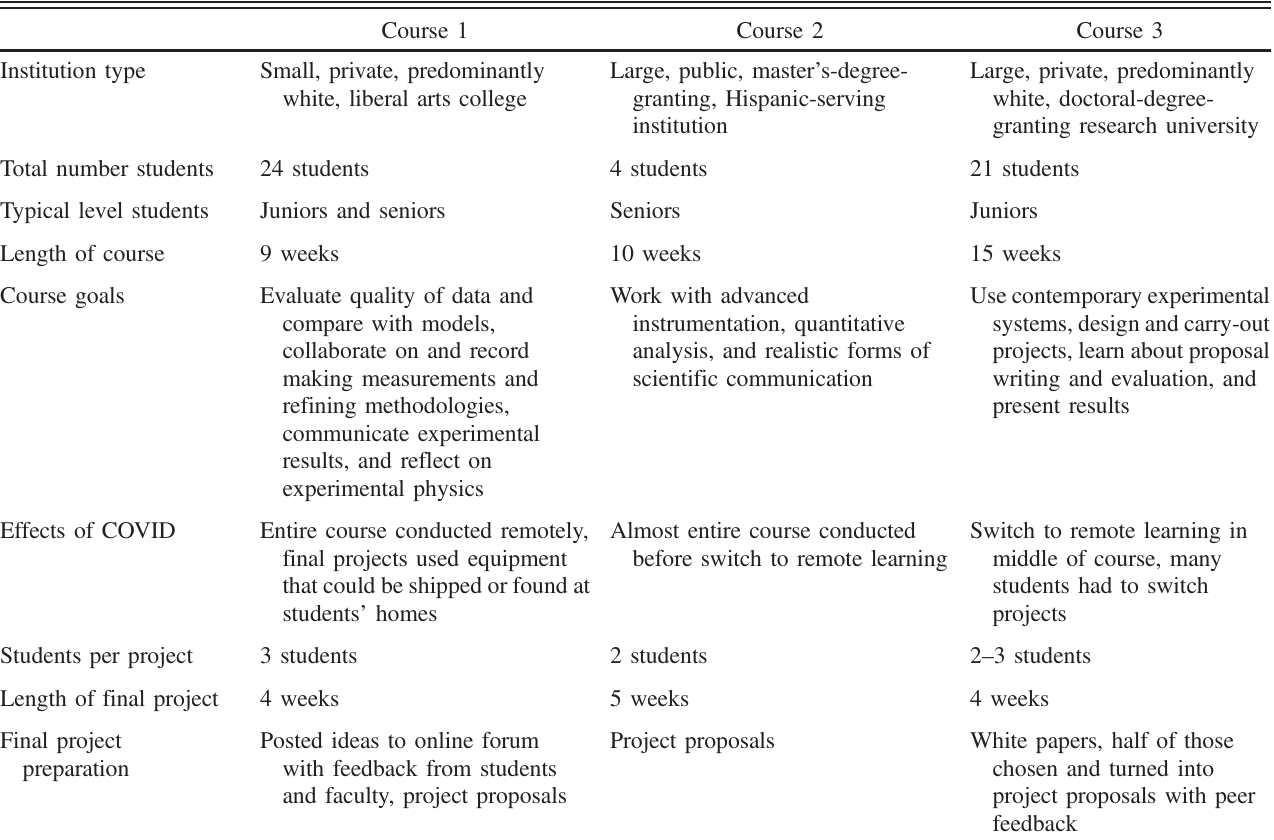
TABLE I. Summary of the three courses from which we collected